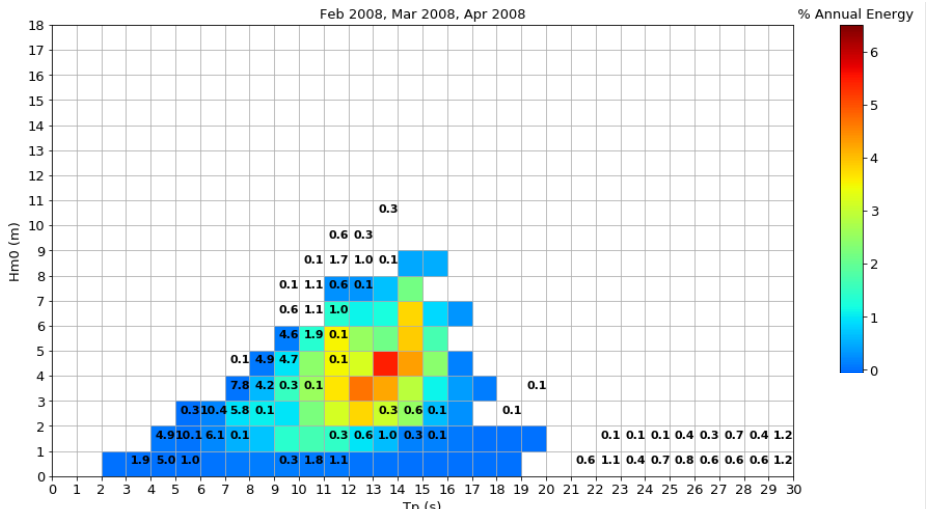
Fig 2. Scaled up South Arran ( H m0 , T p ) % occurrence scatter table (tabulated numbers) for Feb-Apr 2008 overlaid on Billia Croo ( H m0 , T p ) % annual incident energy scatter colour map for 2008.